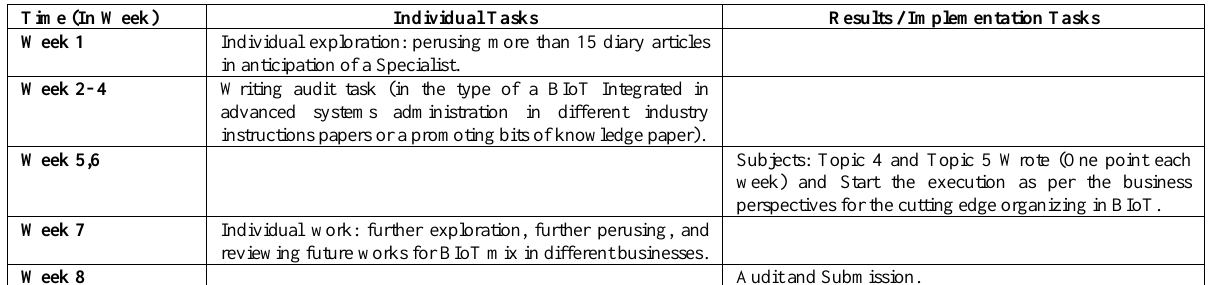
Table 1. Literature review timeline about blockchain IoT (BIoT) integrated into futuristic networking for industry. Time (In Week) Individual Tasks Results / Implementation Tasks Week